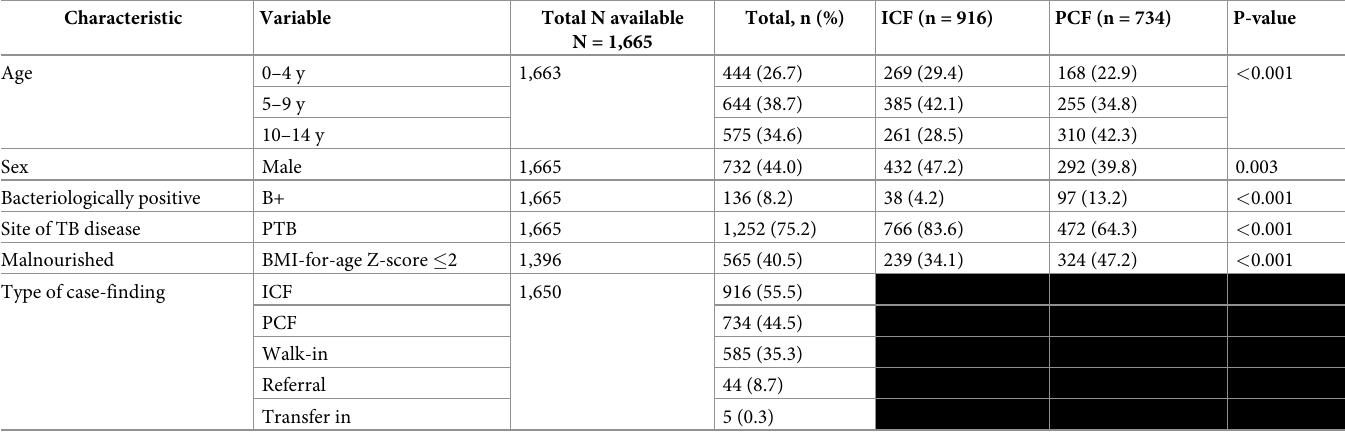
Table 1. Baseline demographics and clinical characteristics of 1,665 children treated for drug-susceptible tuberculosis, stratified by type of case-finding strategy. Characteristic